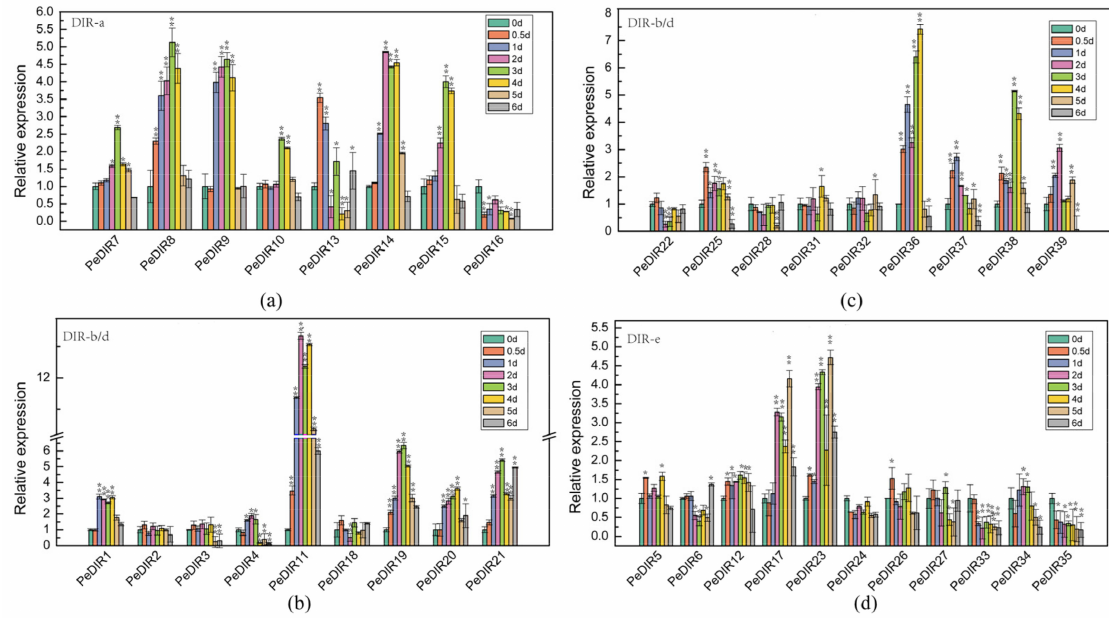
Figure 9. Relative expression levels of the PeDIRs of ‘Nanlin 895’ seedlings subjected to M. brunnea for 0, 0.5, and 1–6 d. Expression of the PeDIRs normalized to those of actin and shown relative to the expression at 0 h. The 2 − ∆∆ Ct method was used to compute the expression levels of PeDIRs at different times. Experiments were repeated at least three times. ( a ) Relative expression levels of PeDIRs of the DIR-a subfamily in response to M. brunnea . ( b , c ). Relative expression levels of PeDIRs of the DIR-b/d subfamily in response to M. brunnea . ( d ) Relative expression levels of PeDIRs of the DIR-e subfamily in response to Marssonina brunnea. Statistically analyzed using student’s t-tests (* p < 0.05, ** p <